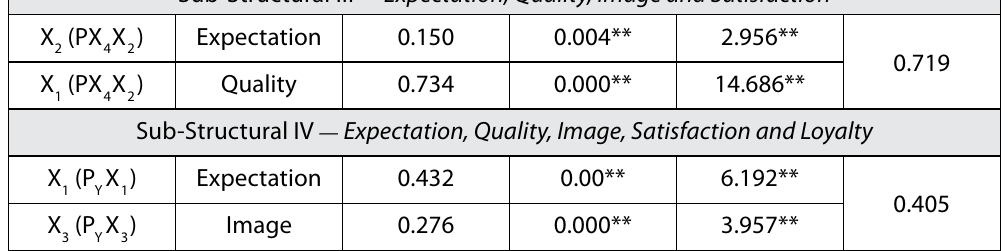
Table 5 Path analysis results subsequent to